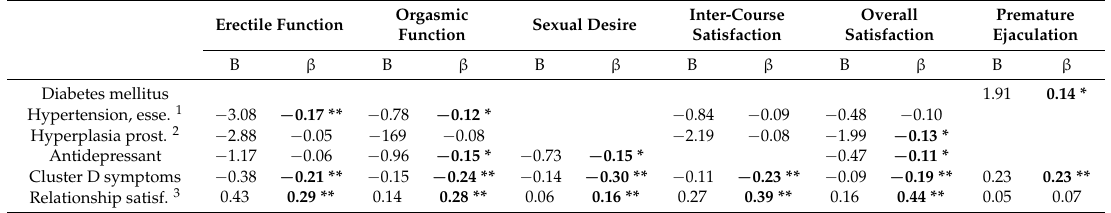
Table 3. Overview of individual significant predictors in the final step of hierarchical regression analysis for the subset sample of veterans in a relationship. Orgasmic Inter-Course Overall Premature Sexual Desire Erectile Function Function Satisfaction Satisfaction Ejaculation B β B β B β B β B β B β Diabetes mellitus